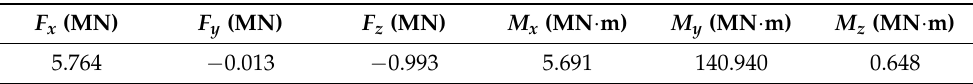
Table 6. Load components of DLC 4.2 for cases A and